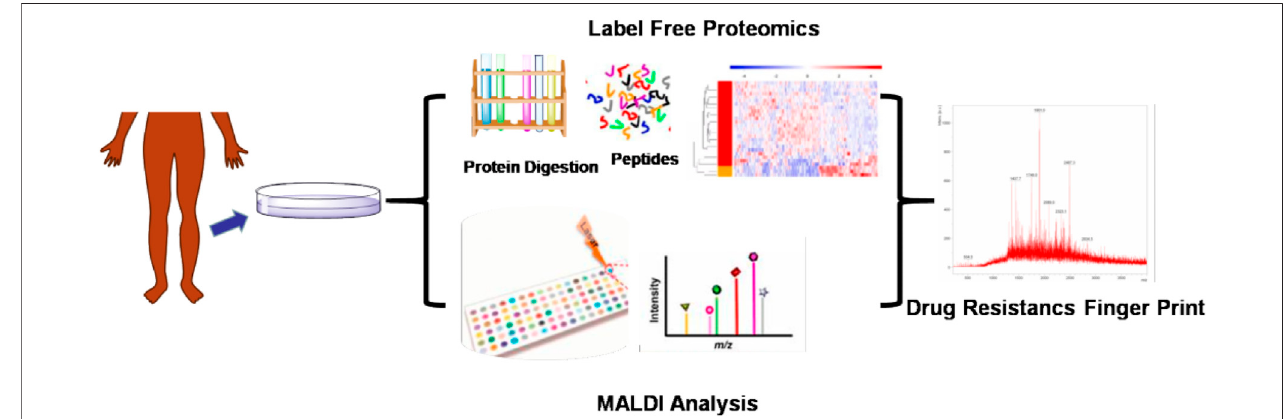
FIGURE 1 | The strategy of the drug resistance fi nger print research for diabetic